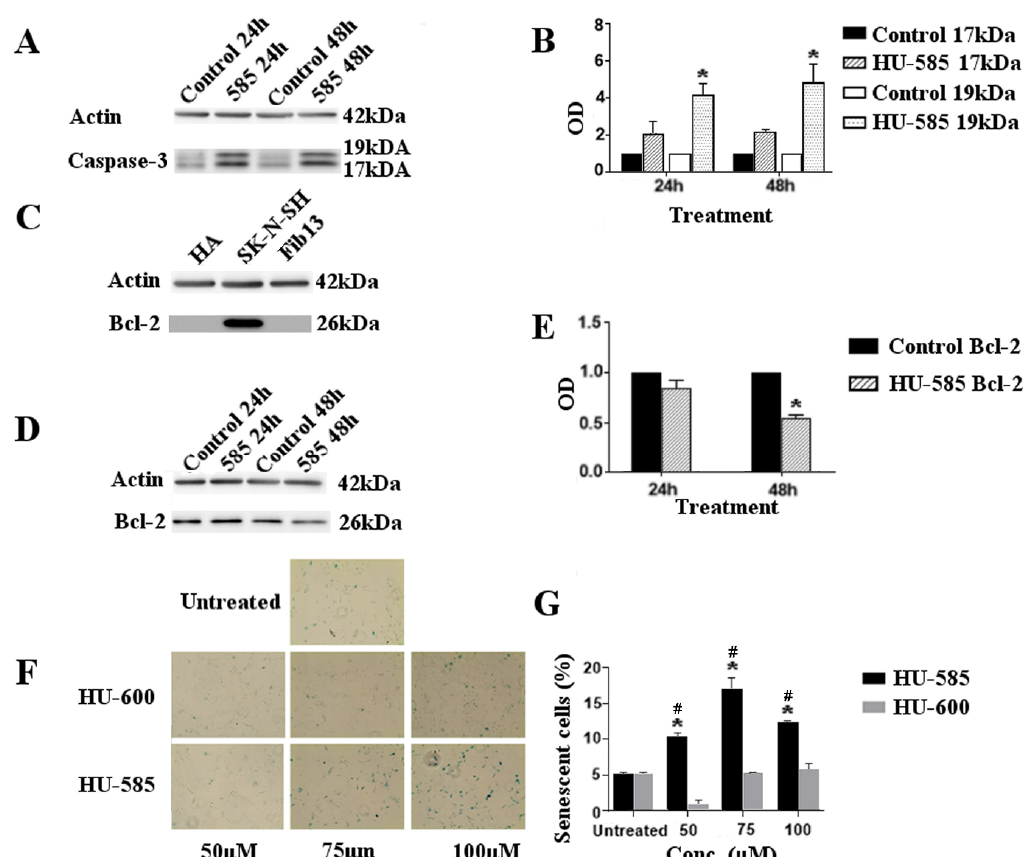
Figure 3. Growth suppression by HU-585 is mediated by apoptosis and senescence. ( A – E ) Apoptotic effects of HU-585. ( A ) Caspase-3 assay. Western blot of caspase-3 (35 kDa) cleavage to 19 kDa and 17 kDa represents the apoptotic effect of HU-585. SK-N-SH cells were treated with 100 µ M of HU-585 for 24 h and 48 h. ( B ) Quantification of cleaved caspase-3. Quantification was done by Image Lab software and representation for 24 h and 48 h of incubation are shown. Cleaved 19 kDa level increased significantly in a time-dependent manner in comparison to its control following treatment with HU-585. Statistical differences at 24 h and 48 h were determined by two-way ANOVA (* p < 0.01). ( C ) Bcl-2 protein levels. Western blot of Bcl-2 protein levels determination for human astrocyte cell line (HA), SK-N-SH cells and fibroblast cell line (as a “normal control”). High levels of Bcl-2 protein were detected in SK-N-SH cells compared to the other cell lines. ( D , E ) Apoptotic effects of HU-585 analyzed by Bcl-2 levels following treatment. ( D ) Western blot of Bcl-2 protein levels in SK-N-SH cells following treatment with 100 µM HU-585 for 24 h and 48 h. ( E ) Quantification of Bcl-2 protein. Quantification was done by Image Lab software following treatment with 100 µM of HU-585 for 24 h and 48 h. Results revealed that the level of Bcl-2 protein decreased in a time-dependent manner, reaching maximal and significant effect at 48 h. Statistical significance was determined by Unpaired t -Test (* p < 0.001). ( F , G ) Senescence effect of HU-585 analyzed by β-galactosidase staining . ( F ) Activity of β-galactosidase in SK-N-SH cells following HU-600 and HU-585 treatment was measured by β-galactosidase staining. SK-N-SH cells were plated in 6-well plates and treated with 50 µM, 75 µM and 100 µM of HU-600, HU-585 or no treatment as control. Positivity for β-galactosidase following 48 h of treatment represents the cells that are in senescence. ( G ) Representation of the quantified percentages of senescent cells. Results show an increased number of senescent cells following HU-585 treatment compared to HU-600 treatment and untreated cells. Data is reported as mean ± SE of triplicates. Statistical significance was determined by GEE test. * p < 0.05 compared to HU-600 and # p < 0.05 compared to untreated cells .